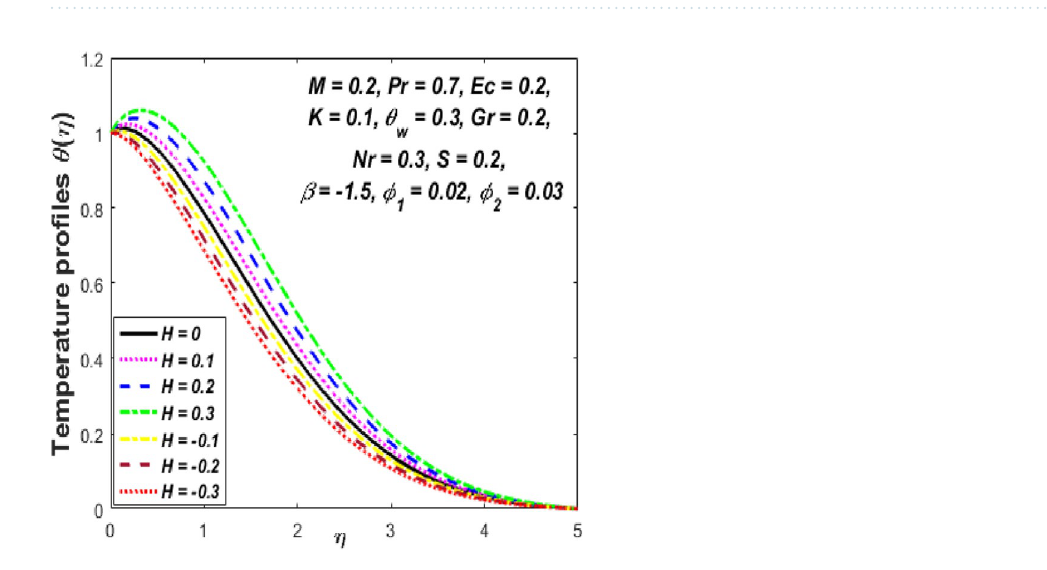
Figure 7. Influence of Ec on temperature θ ( η ) profile.